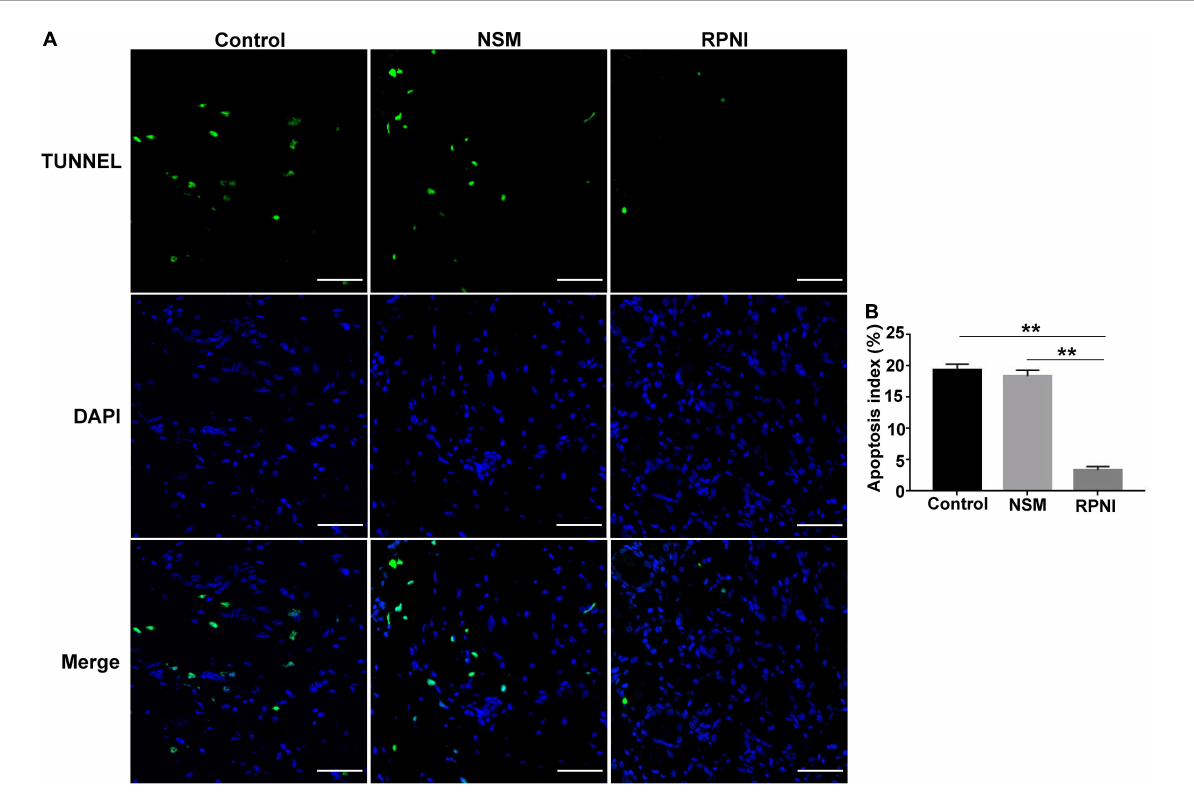
FIGURE3 The results of TUNEL assay in the ipsilateral L4 DRGs among the three groups at 8 weeks post-axotomy. (A) Fluorescent images of neurons in the ipsilateral L4 DRG taken from each group. (B) Apoptosis index (TUNEL-positive neurons/total neuron number [DAPI]) in each group. (** p < 0.01. Scale bar = 50 µ m). DAPI, 4 (cid:48) ,6-Diamidine-2 (cid:48) -phenylindole dihydrochloride; DRG, dorsal root ganglia; NSM, nerve stump implantation inside the muscle; RPNI, regenerative peripheral nerve interface.